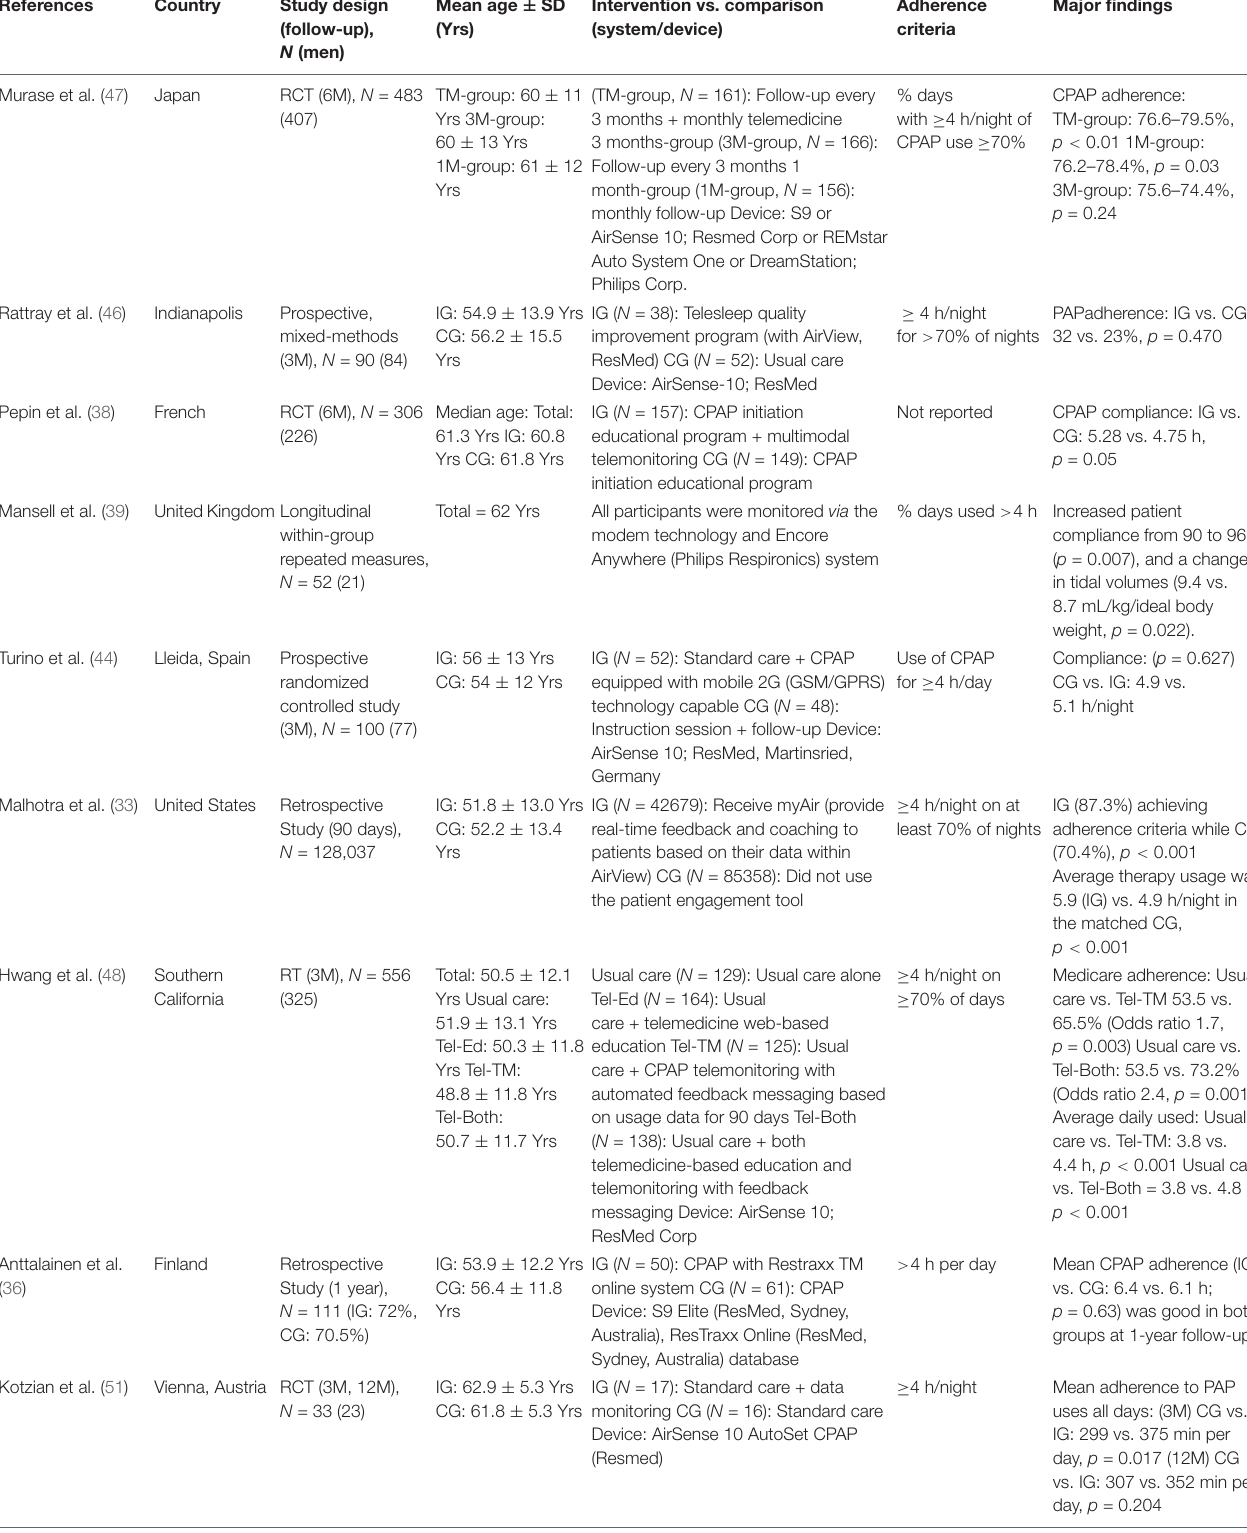
TABLE 1 | Summary of telemonitoring